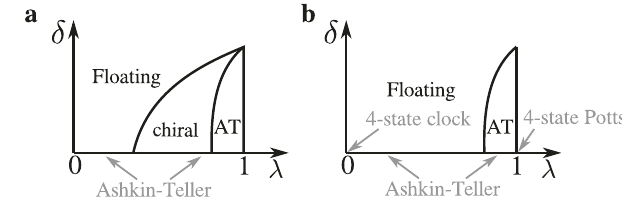
Fig. 1 Scenarios for the phase transition in the presence of a chiral perturbation. Sketches of the possible phase diagrams of the transition out of period-4 phase as a function of the parameter λ that describes the Ashkin – Teller universality class in the absence of a chiral perturbation, and of the amplitude δ of the chiral perturbation a with and b without a chiral transition. The width of the Ashkin – Teller (AT) phase has been exaggerated for visibility. Along the horizontal axis, the transition is always in the Ahskin – Teller universality class, ranging from the four-state clock model at λ = 0 to the four-state Potts model at λ =